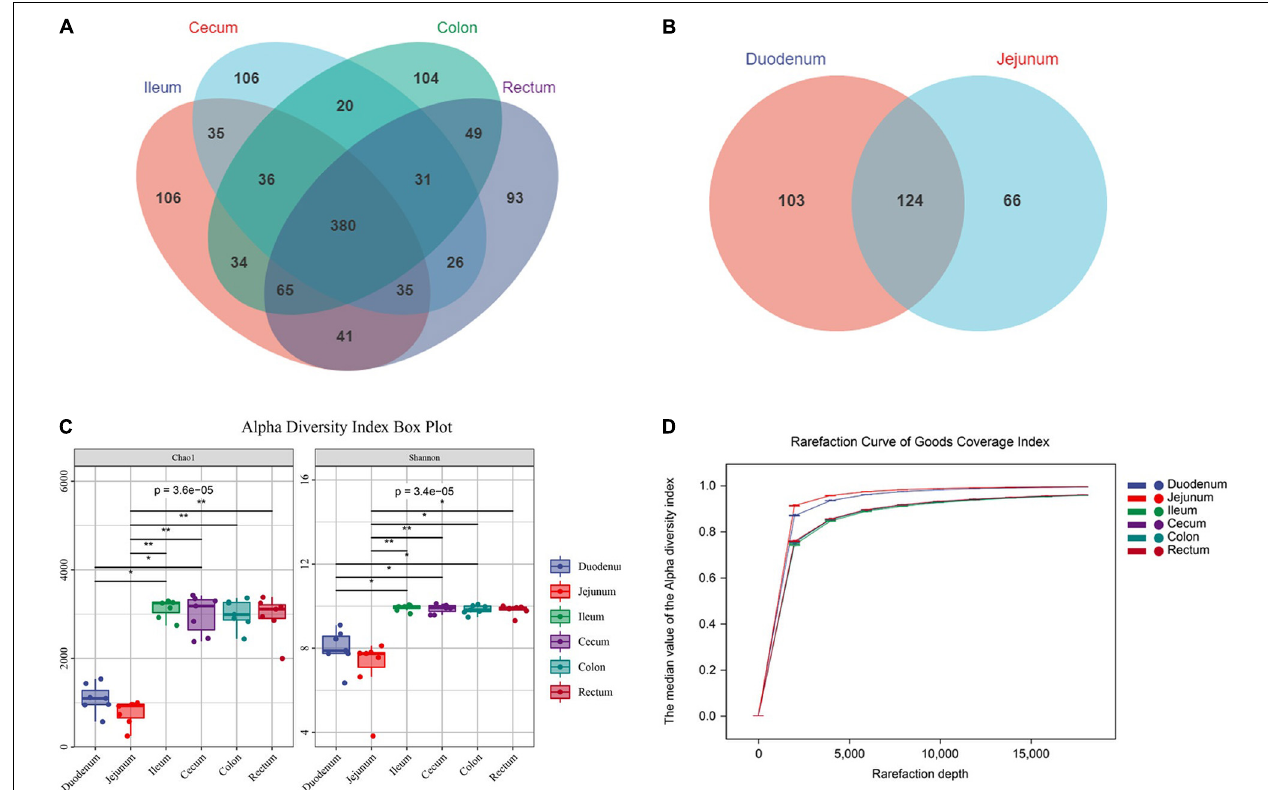
FIGURE 2 | Sequencing results and statistical analysis of diversity. (A) Venn diagram showing the OTUs shared among the hindgut segments. (B) Venn diagram showing the OTUs shared between the foregut segments. (C) The Chao1 and Shannon indices of six intestinal segments. Significantly different indices were tested by Kruskal-Wallis test with adjusted * P value of < 0.05, ** P > 0.01. (D) Rarefaction curve of Good’s coverage index. Each curve represents the mean within the